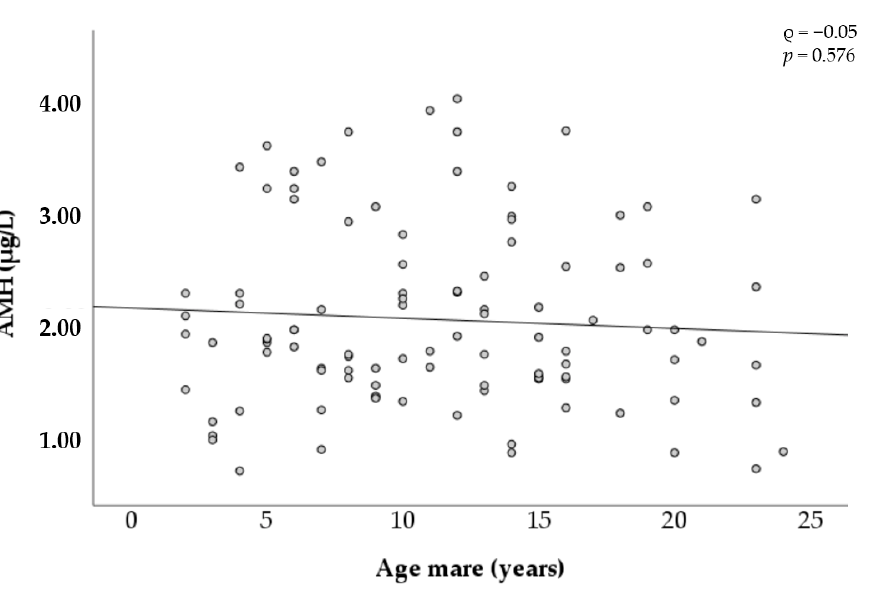
Figure 4. Relationship between age and AMH concentration in